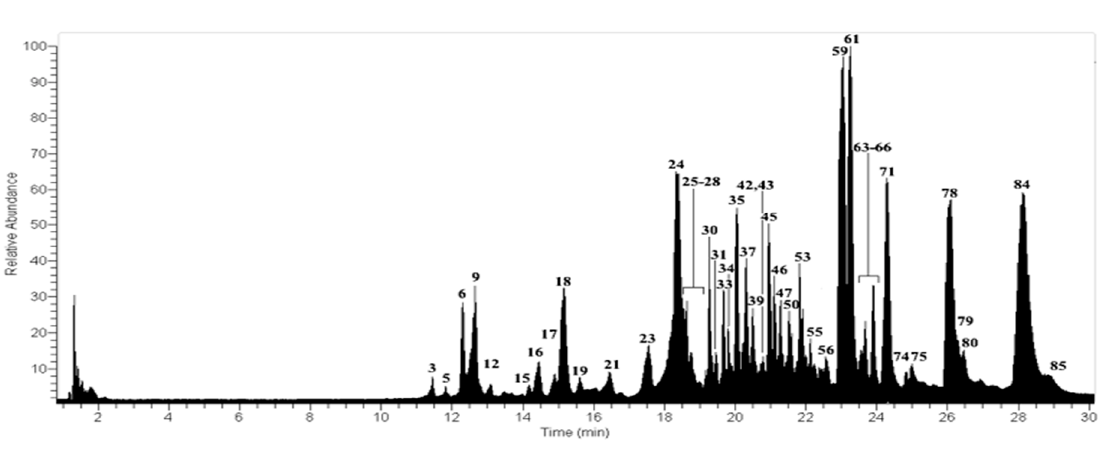
Figure 3. UHPLC-MS Chromatogram of U. rubicunda.